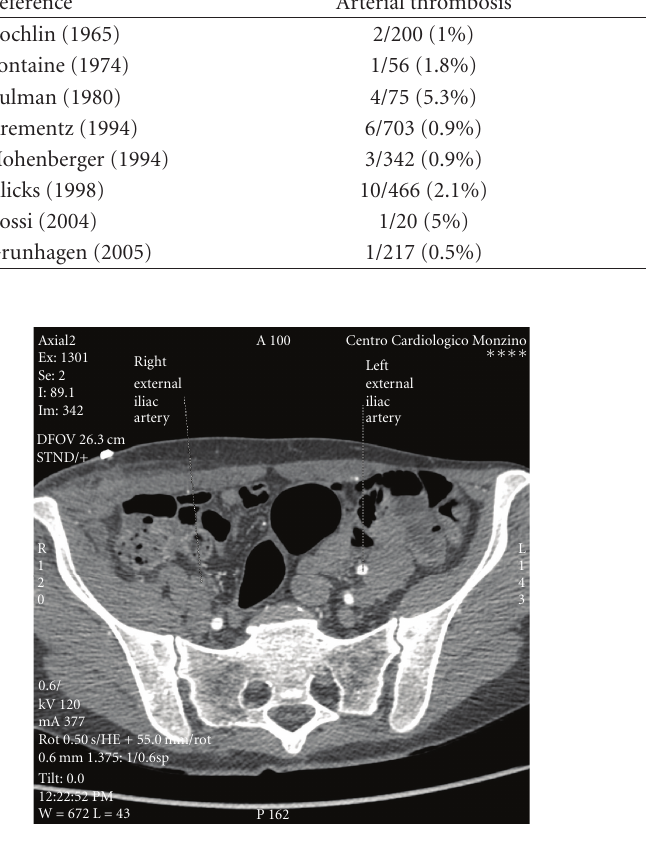
Figure 1: Axial view of right external iliac artery thrombosis. No contrast-enhancement is visible. Figure 2: Postprocessing 3D reconstruction of the iliac stenosis and the collateral circulation reperfusing mainly the profunda femoris from the omolateral internal iliac